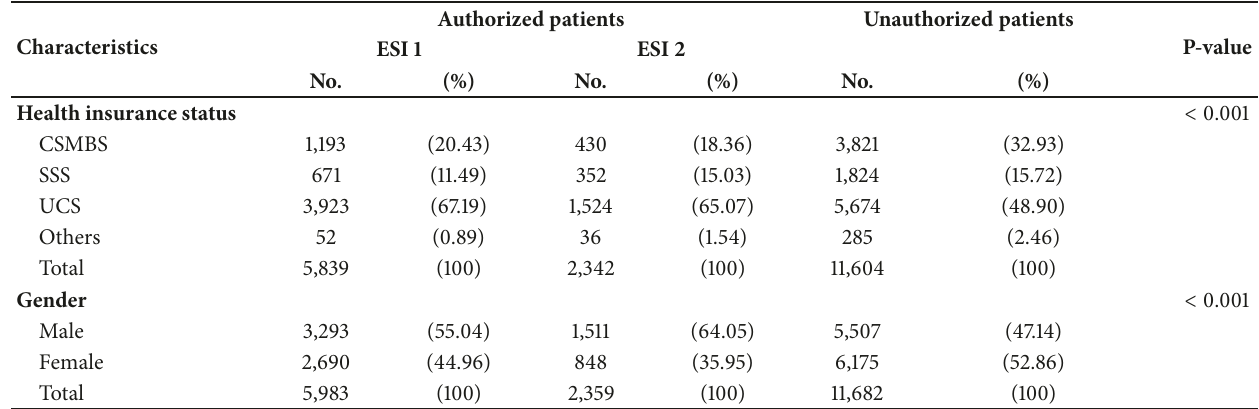
Table 2: Selected characteristics of authorized and unauthorized patients.